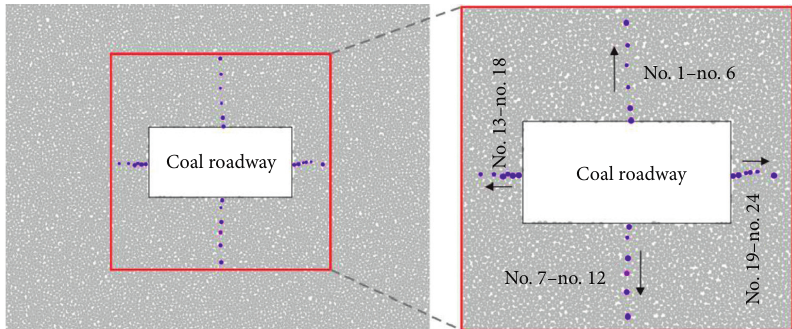
Figure 11: Inspection point locations in the rock surrounding the coal